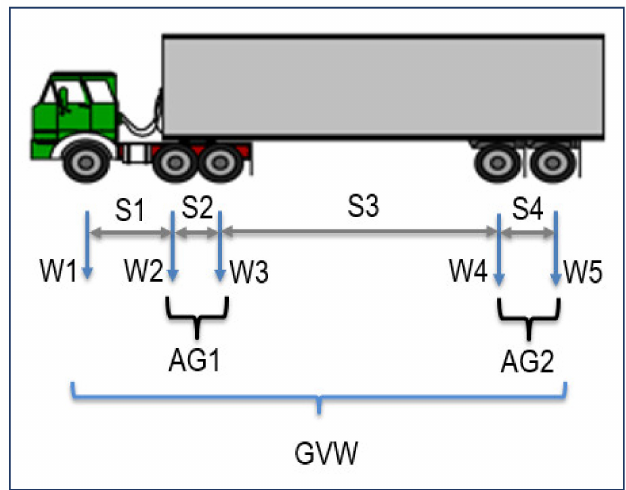
Figure 7. Attributes of the vehicle considered during